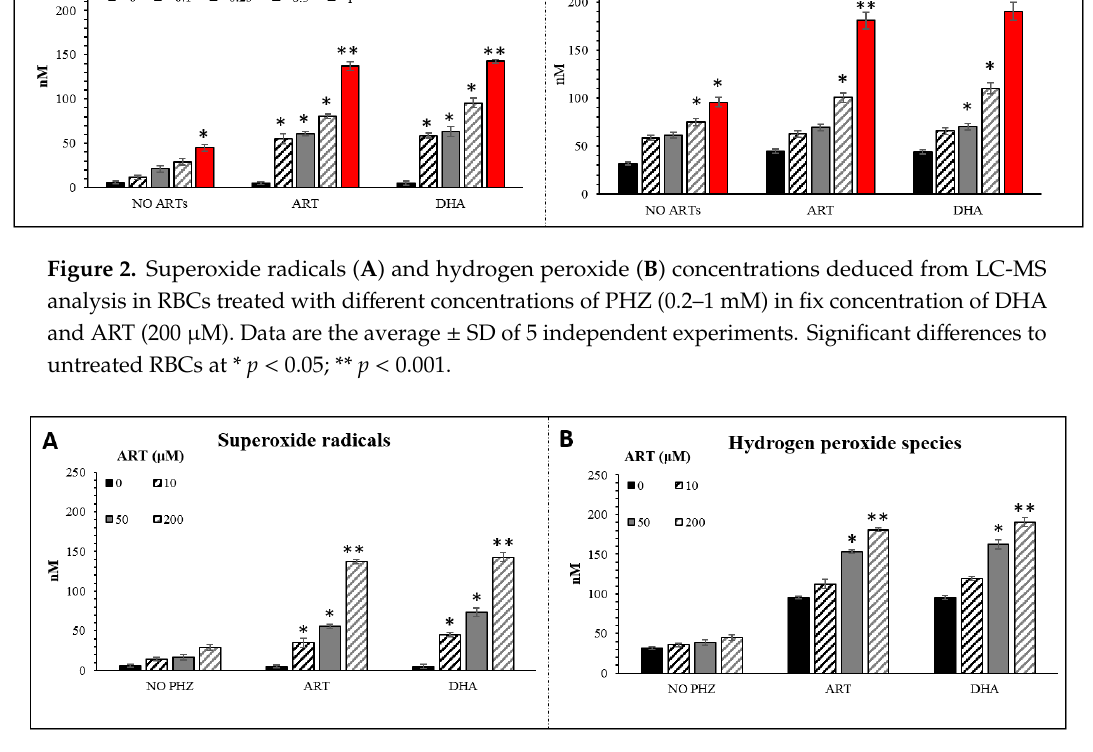
Figure 3. Superoxide radicals ( A ) and hydrogen peroxide ( B ) concentrations deduced from LC-MS analysis in RBCs treated with ARTs (0.2–1 mM) and PHZ (1 mM). Data are the average ± SD of 5 independent experiments. Significant differences to untreated RBCs at * p < 0.05; ** p < 0.001.